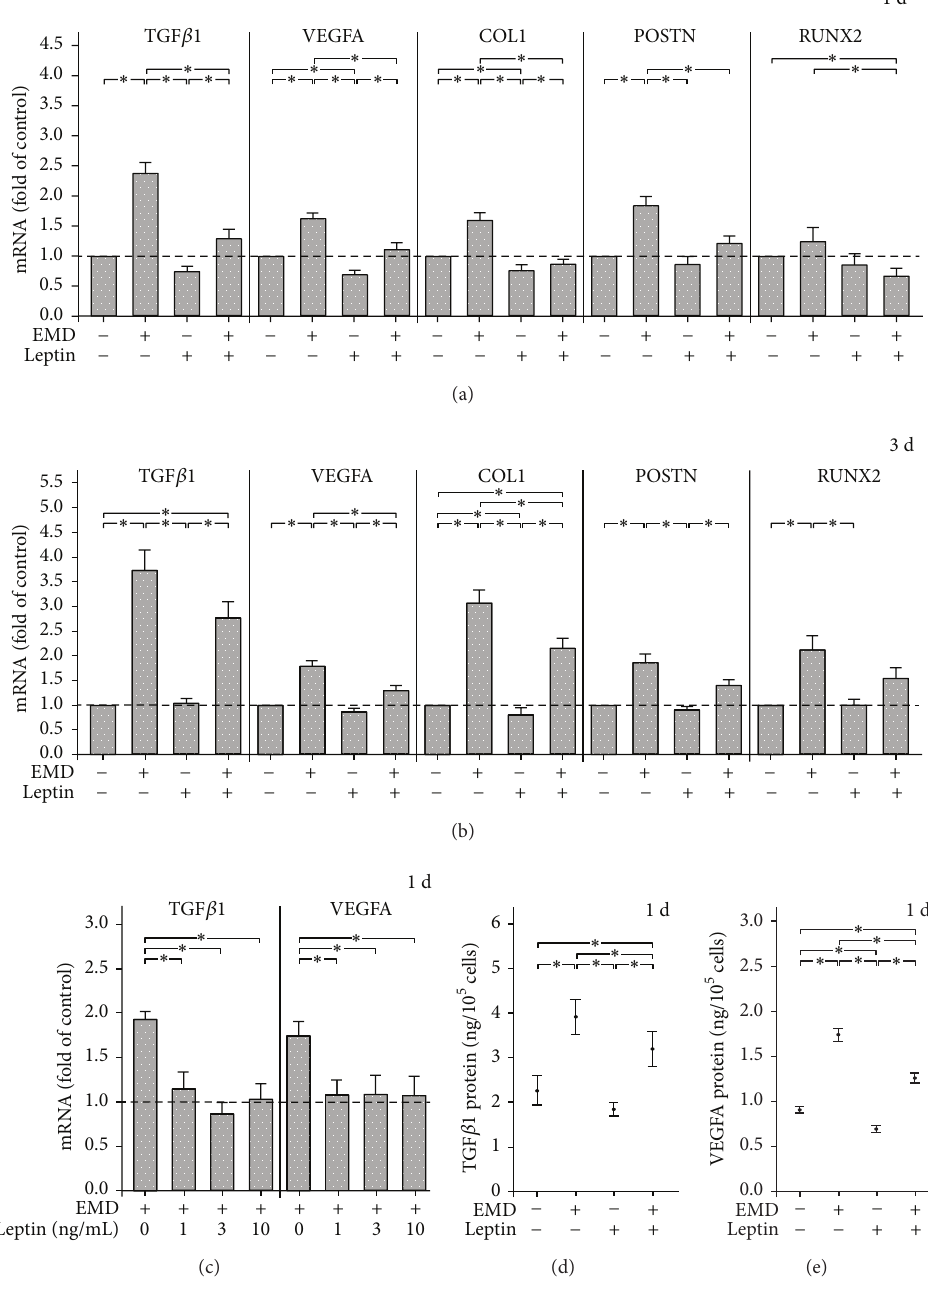
Figure 1: Effect of EMD and/or leptin (3 ng/mL) on TGF 𝛽 1, VEGFA, COL1, POSTN, and RUNX2 mRNA at 1d (a) and 3 d (b). Untreated cells served as control. Mean ± SEM ( 𝑛 = 18 ); ∗ significant ( 𝑃 < 0.05 ) difference between groups. Effect of various concentrations (0, 1, 3, and 10ng/mL) of leptin on TGF 𝛽 1 and VEGFA mRNA in EMD-treated cells at 1d (c). Mean ± SEM ( 𝑛 = 9 ); ∗ significant ( 𝑃 < 0.05 ) difference between groups. Effect of EMD and/or leptin (3ng/mL) on protein levels of TGF 𝛽 1 (d) and VEGFA (e) released from cells into the medium at 1 d. Untreated cells served as control. Mean ± SEM ( 𝑛 = 18 ); ∗ significant ( 𝑃 < 0.05 ) difference between groups.